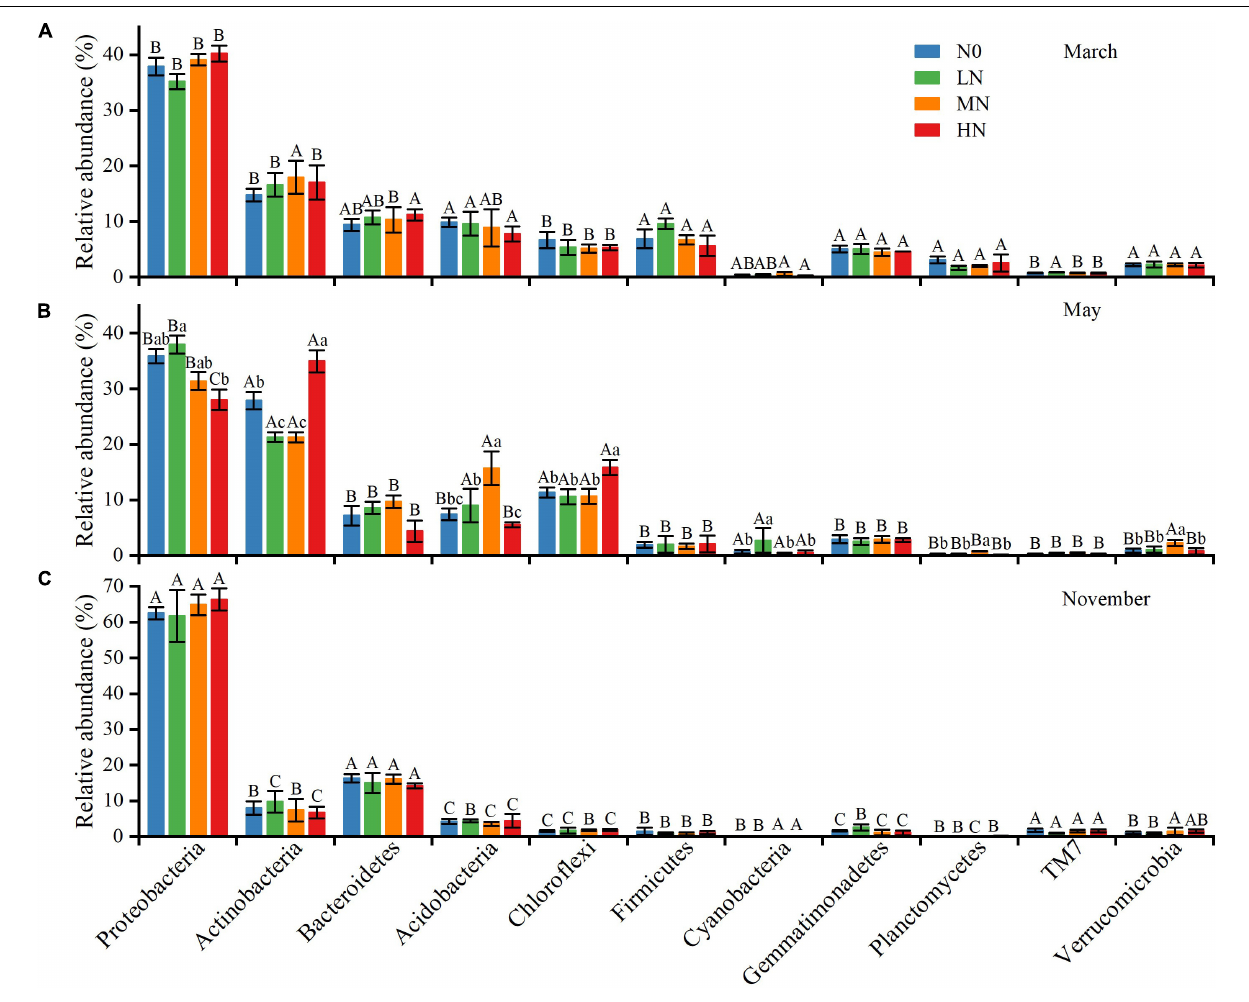
FIGURE 3 | The average relative abundance (%) of bacterial taxa at the phylum level ( n = 3), March (A) , May (B) , and November (C) . N0 = 0 g N m - 2 year - 1 ; LN = 1.8 g N m - 2 year - 1 ; MN = 3.6 g N m - 2 year - 1 ; HN = 7.2 g N m - 2 year - 1 . Different capital letters indicate a significant difference among the three sampling months; different lowercase letters indicate a significant difference in soil bacterial relative abundance among four N treatments in the same sampling month. Vertical bars show the standard error (SE) ( n =